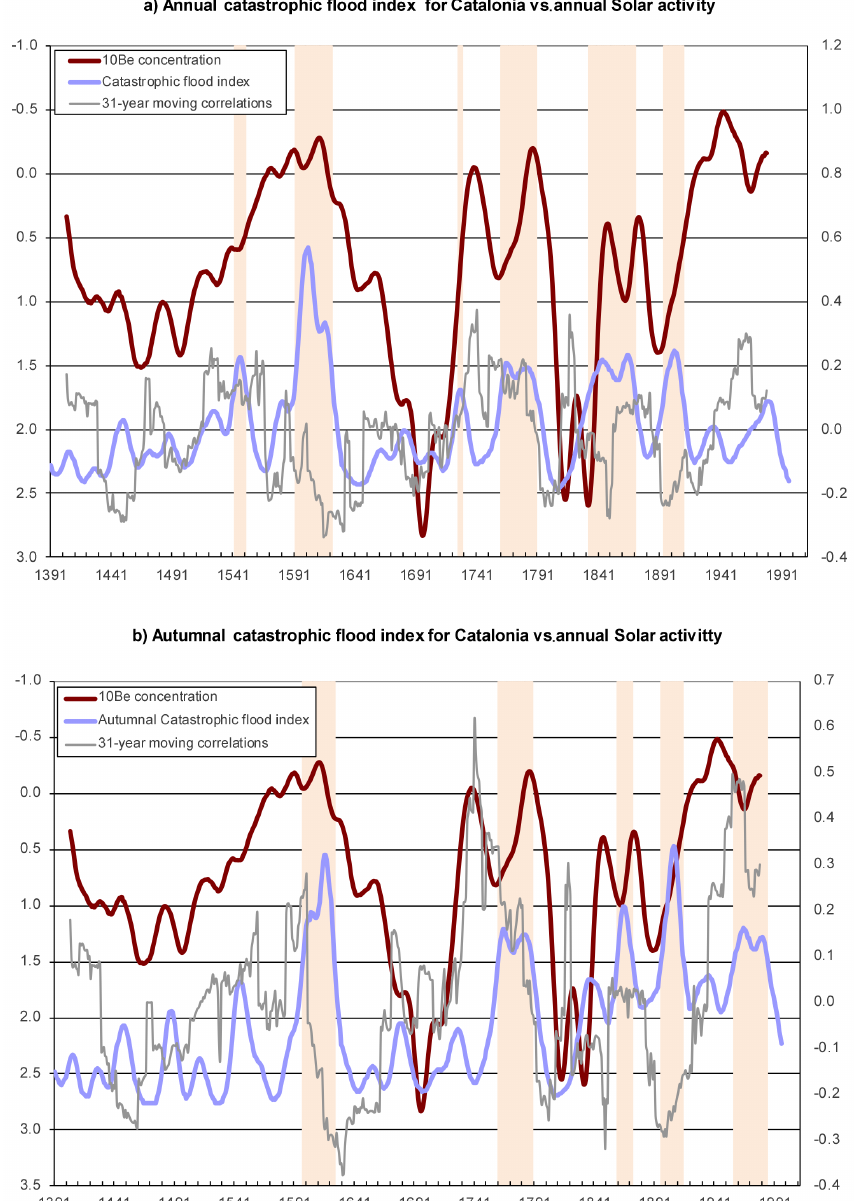
Figure 10. Temporal evolution (1389–2012) of solar activity taken from 10 Be (Berggren et al., 2009; brown lines) versus annual (a) and autumnal (b) catastrophic flood index series for Catalonia (blue lines). The temporal evolution of the 31 year moving correlations between solar activity and floods are also displayed (grey lines). Solar activity and flood data are smoothed by a 31 year low-pass Gaussian filter. The scale for 10 Be concentration is inverted because its concentration is high for periods of minimum solar activity, and low for periods of maximum solar activity. The anomalous periods of high flood frequency are highlighted in both